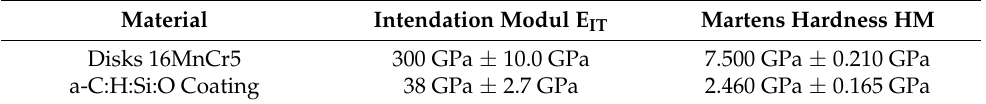
Table 2. Elastic-plastic properties of the surfaces.